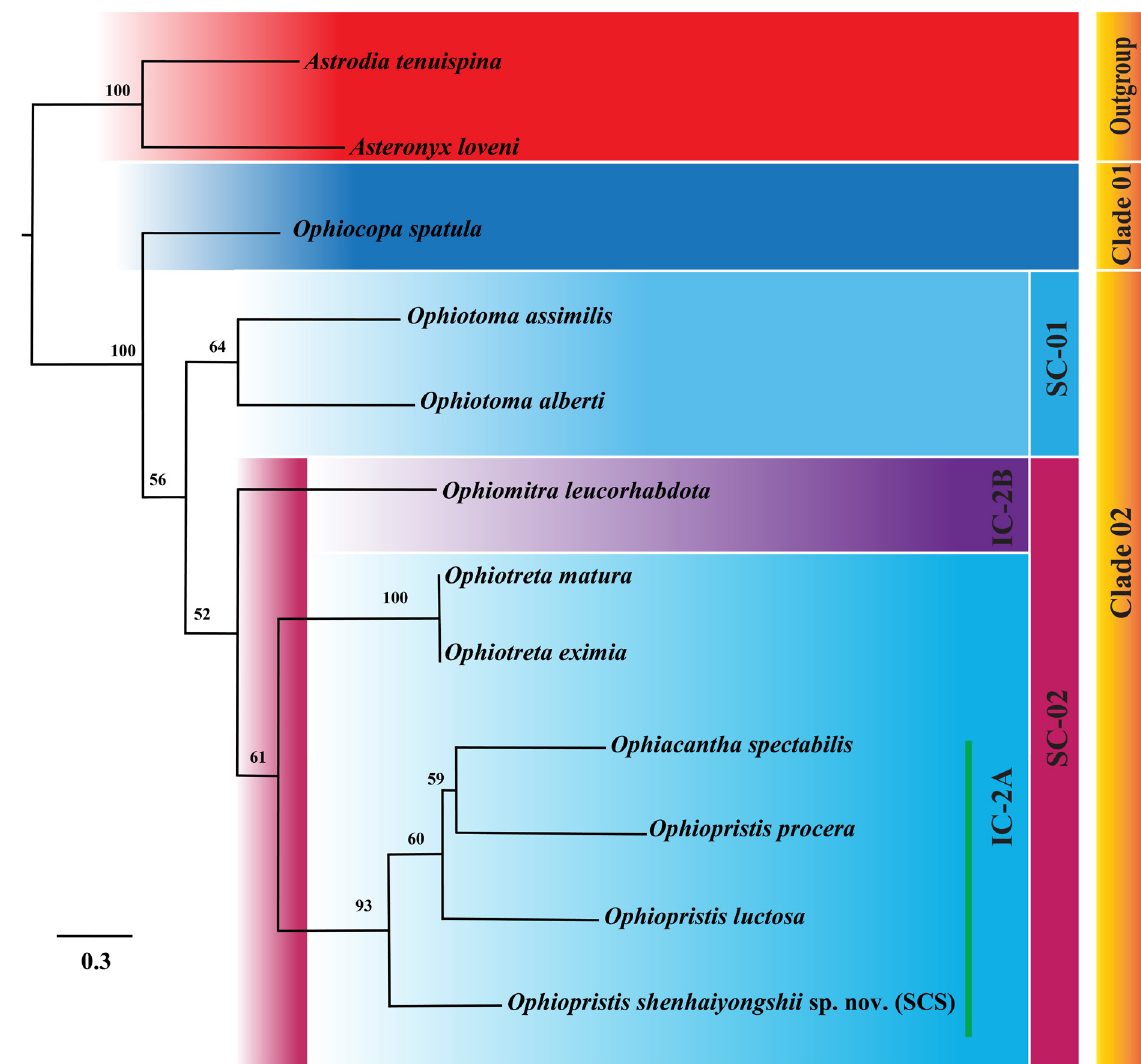
Fig. 46. Family Ophiotomidae Paterson, 1985, Maximum likelihood (ML) tree based on partial COI sequences (bootstrap support values were generated with rapid bootstrapping algorithm for 1000 replicates). Abbreviations: IC = Inter Clade; SC = Sub-Clade; SCS = South China